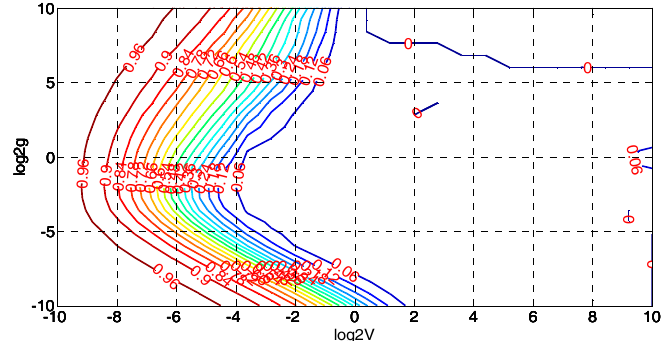
Figure 10. The contour of the optimal parameters.